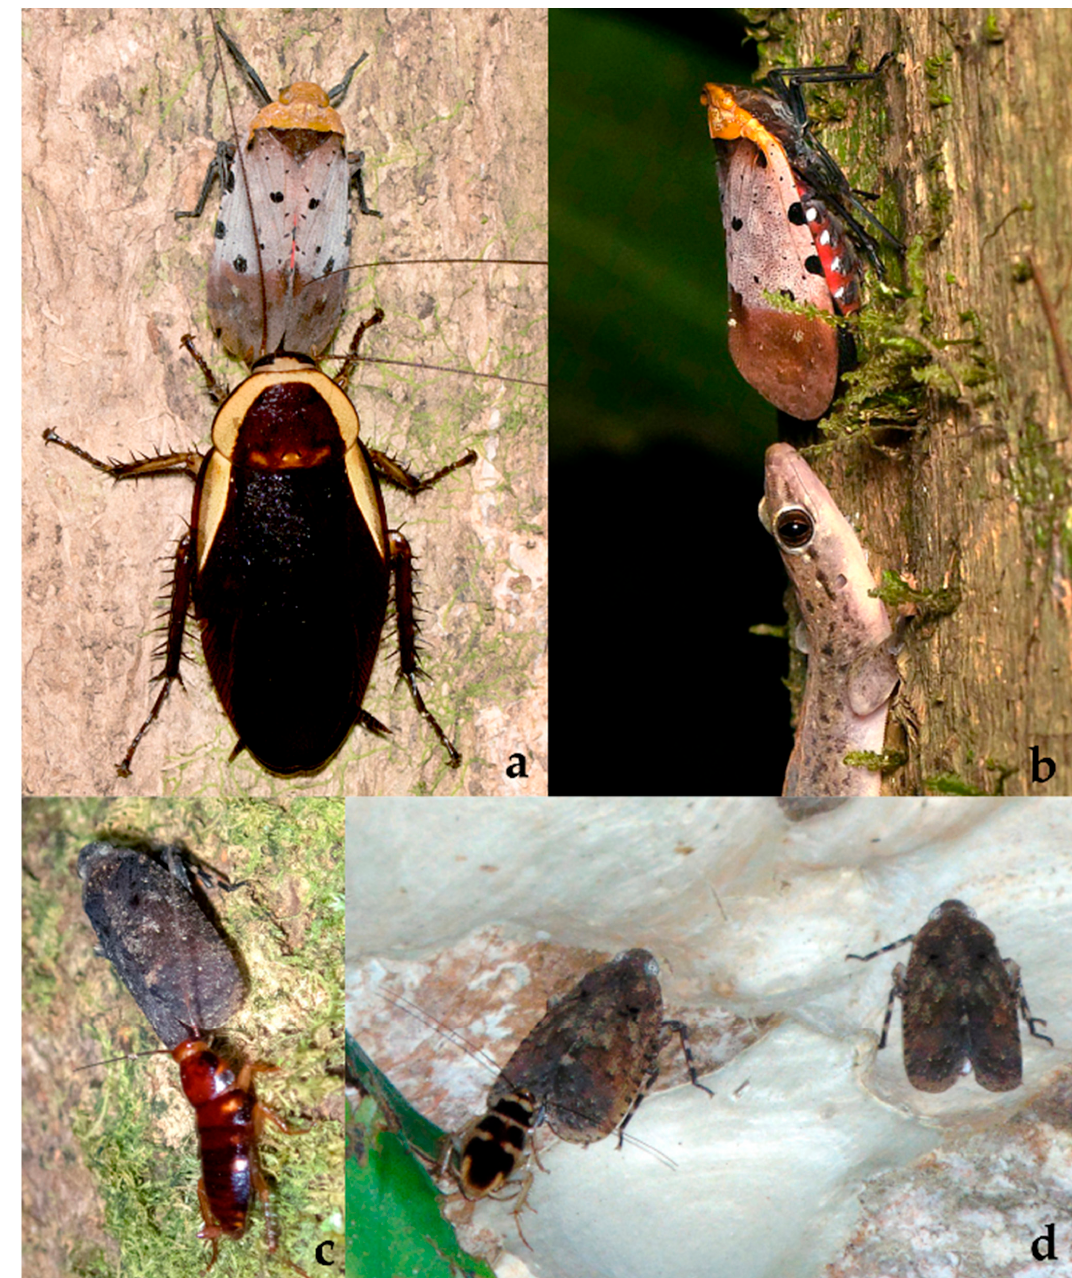
Figure 13. Fulgoridae: ( a ) Penthicodes atomaria (Weber, 1801) tended by Blattodea indet., Thailand: Khao Sok National Park, 12.02.2018, adult on tree trunk, obs. C. Hübner; ( b ) P. atomaria tended by Reptilia: Squamata: Gekkonidae indet., Thailand: Khao Sok National Park, 8°56 ′ 12 ″ N 98°31 ′ 49 ″ E, 24.02.2020, adult on tree trunk, obs. C. Hübner; ( c ) P. pulchellus (Guérin-Méneville, 1838) tended by Blattodea indet., Cambodia: Koh Kong Province, Tatai, 11°35 ′ 13 ″ N 103°05 ′ 50 ″ E, 13.11.2017, adult on tree trunk, obs. G. Chartier; ( d ) P. pulchellus tended by Blattodea indet., Cambodia: Ratanakiri, Yeak Laom Lake, 13 ◦ 44 (cid:48) N 107 ◦ 01 (cid:48) E, 10.10.2017, adult on tree trunk, obs. J.